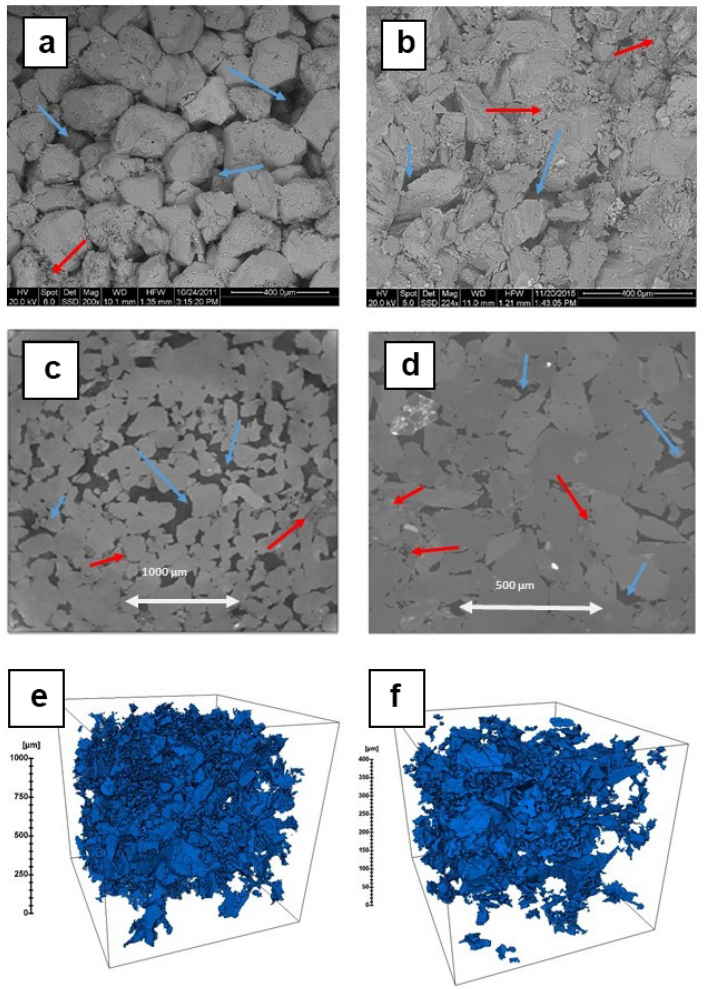
Figure 2. SEM (a) and 2-D (c) and 3-D (e) CT views on the minerals and pore structure of the investigated sample of Bentheimer sandstone, and SEM (b) and 2-D (d) and 3-D (f) CT views on the minerals and pore structure of the investigated sample of Röttbacher sandstone. Blue arrows indicate open-pore spaces, red arrows indicate clay agglomerations and pore